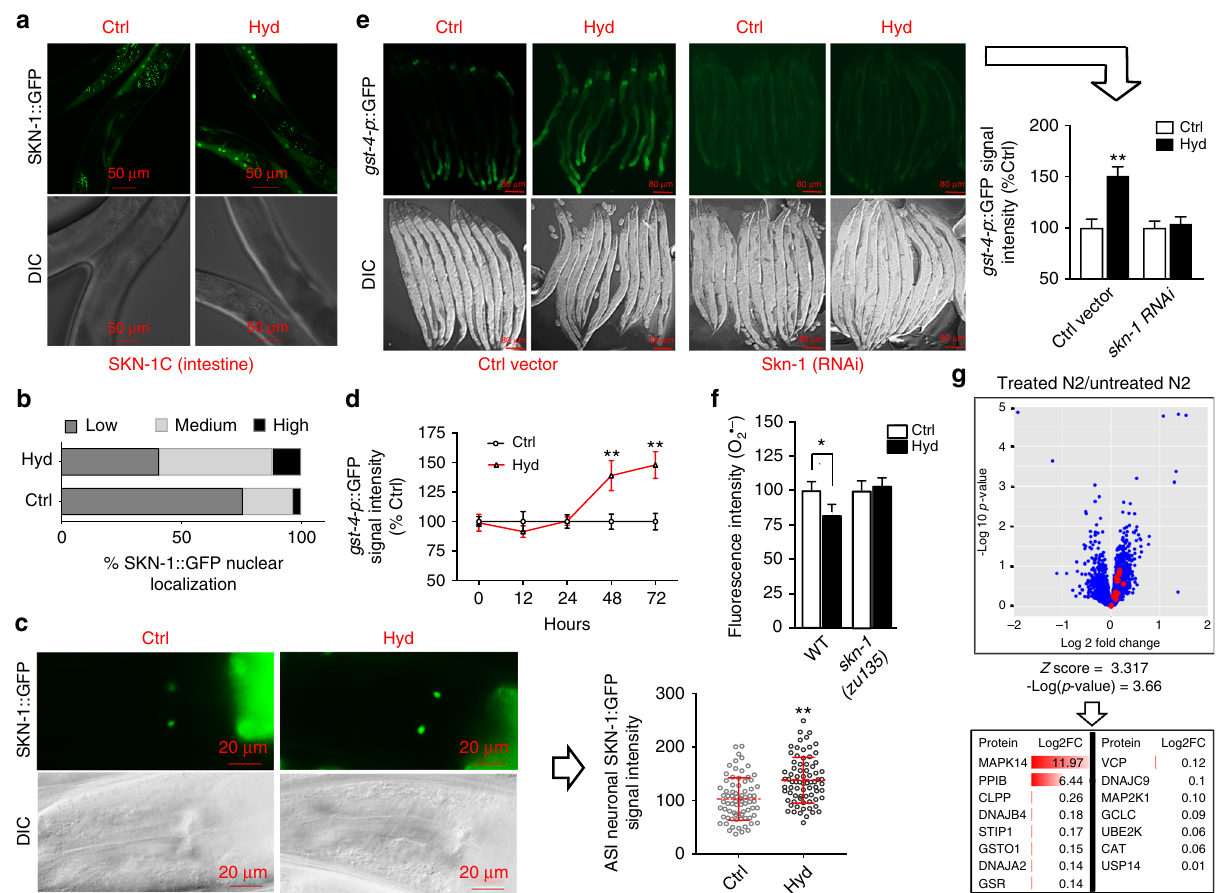
Fig. 4 SKN-1 pathway is activated with hydralazine treatment in C . elegans . In all experiments animals were treated with 100 µ M hydralazine for 72 h unless otherwise stated. a Fluorescent photomicrograph showing hydralazine treatment increases SKN-1::GFP localization in the intestinal nuclei in